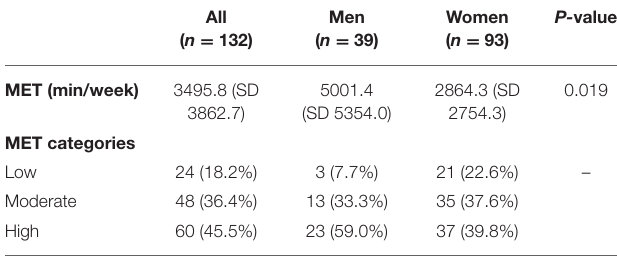
TABLE 5 | Total MET and MET categories among government workers during MCO.